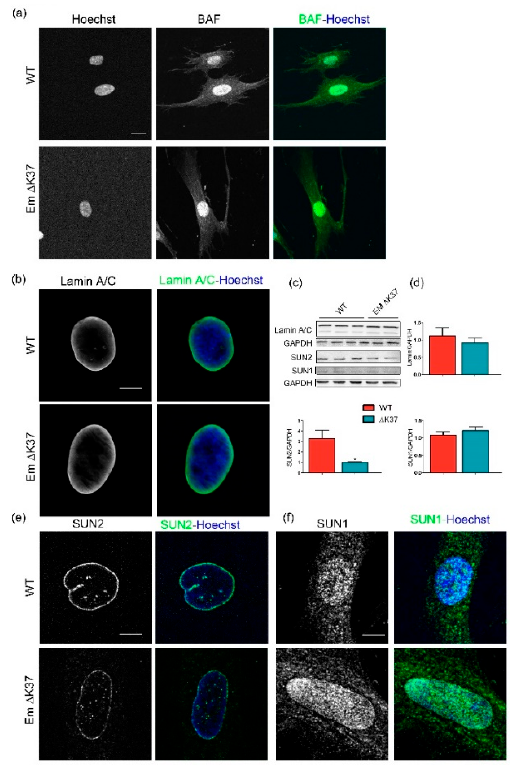
Figure 4. ∆ K37 mutation does not impact the localization of BAF, localization and level of lamin A / C and SUN1, but causes a significant reduction in SUN2 in cells grown on hard substrate. ( a ) Representative images of wild-type and ∆ K37 myofibroblasts stained for BAF (green); nuclei (blue); scale bar, 20 µ m. ( b ) Representative images of wild-type and ∆ K37 myofibroblasts stained for lamin A / C (green); nuclei in blue; scale bar, 30 µ m. ( c ) Representative western-blot of lamin A / C, SUN1 and SUN2 in wild-type and ∆ K37 myofibroblasts. GAPDH was used as an internal control. ( d ) Protein levels of lamin A / C ( n = 10 in wild-type, n = 8 in ∆ K37), SUN1 ( n = 5 in wild-type, n = 4 in ∆ K37) and Sun2 ( n = 7 in wild-type, n = 5 in ∆ K37) in wild-type (red) and ∆ K37 (blue) myofibroblasts, as quantified from the western blot assays; * p -value < 0.05. ( e ) Representative images of wild-type and ∆ K37 myofibroblasts stained for SUN2 (green); nuclei in blue; scale bar, 30 µ m. ( f ) Representative images of wild-type and ∆ K37 myofibroblasts stained for SUN1 (green); nuclei in blue; scale bar, 30 µ